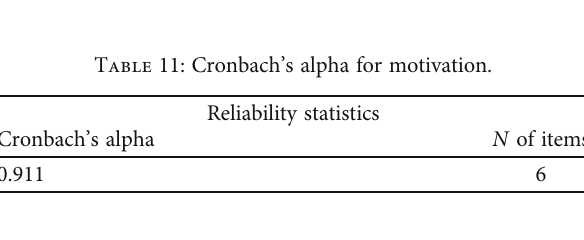
Table 12: Item-total statistics for job satisfaction. Scale mean